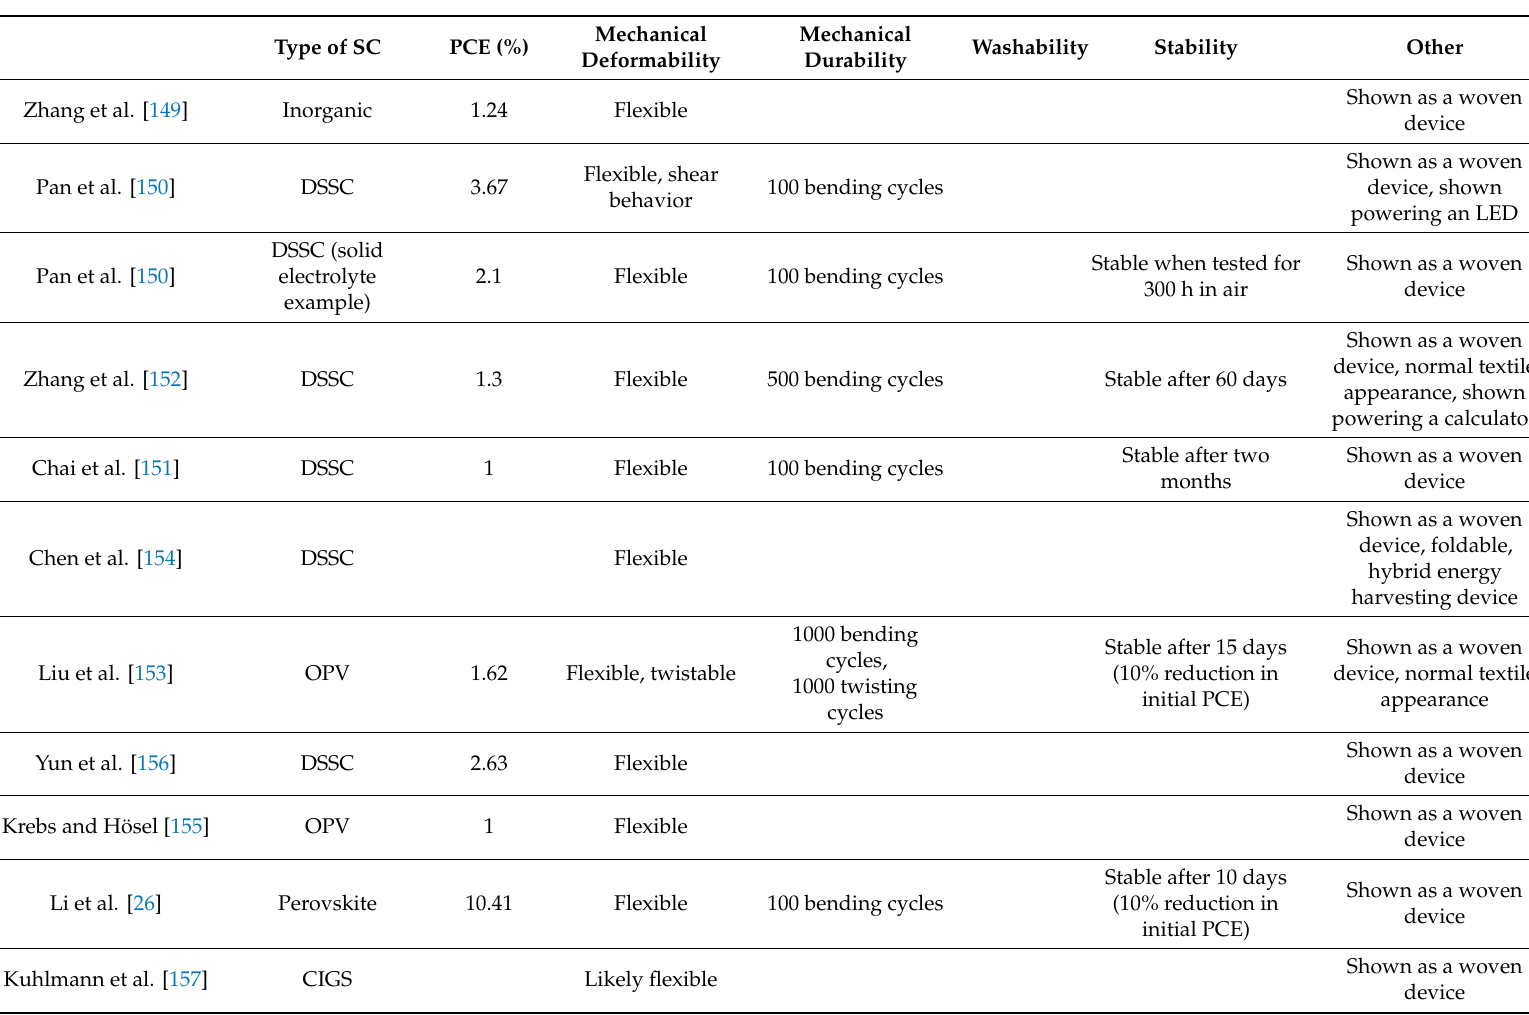
Table 3. Summary of key information regarding the reported properites of various textile woven using photovoltatic fibers, ribbons, or tapes. Please note that PCE (%) are the values given and do not account for any di ff erences in how the PCE may have been calculated between